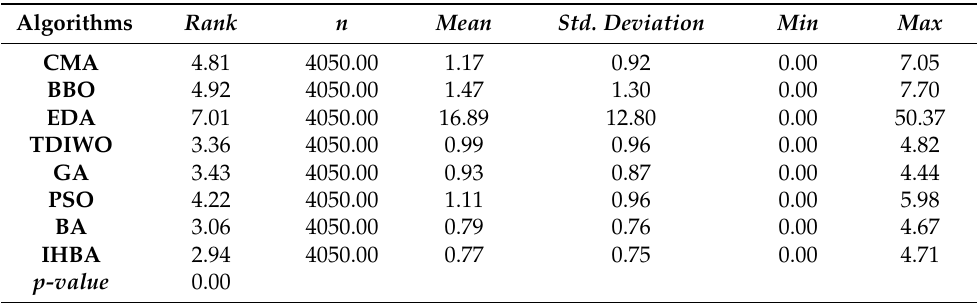
Table 8. The Descriptive Statistics Achieved by the Friedman Test at C = 40 and α = 0.05. The bold figures indicate the comparison between